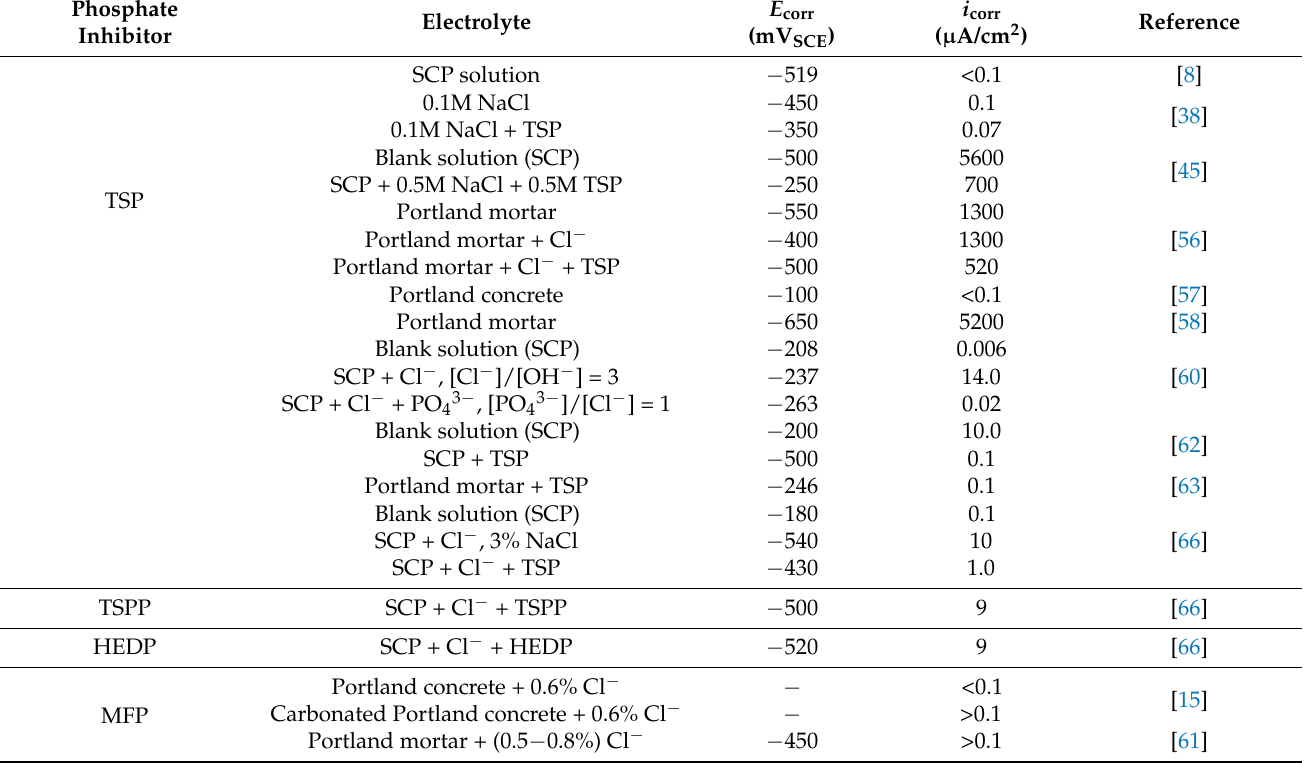
Table 2. Corrosion potential ( E corr , mV vs. SCE) and corrosion current density ( i corr , µ A/cm 2 ) for different solu- ble phosphates: trisodium phosphate (Na 3 PO 4 ) (TSP), tetrasodium pyrophosphate (polyphosphate) (Na 4 P 2 O 7 )